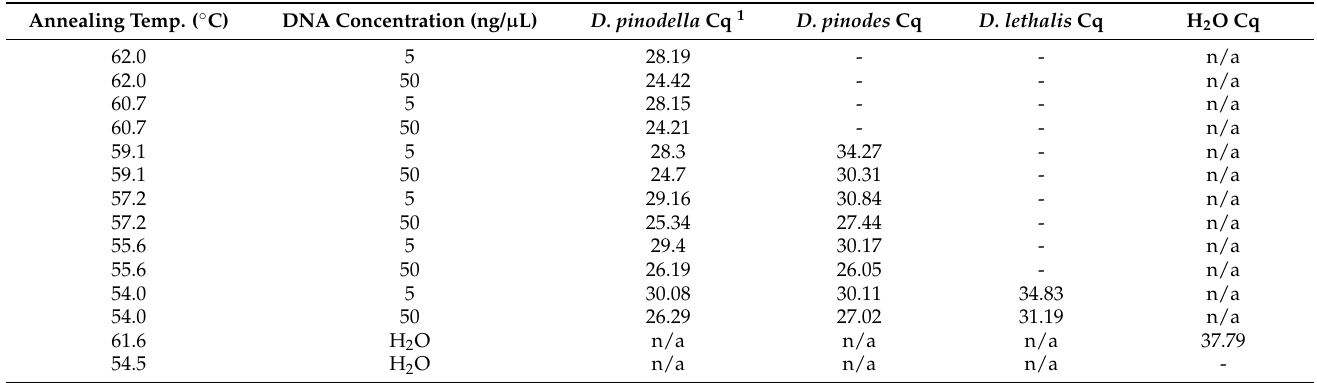
Table 3. Quantification cycle (Cq) values of DpinodellaTef primer and probe set evaluated in the speci- ficity assay on a 3 isolates/3 species exclusion panel. The optimum primer annealing temperatures and two different fungal DNA concentrations were also tested.